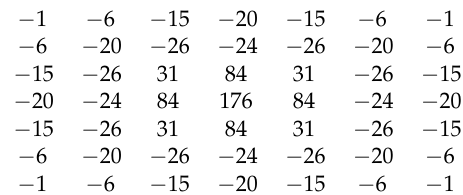
Table 3. Coefficients of the 7 × 7 convolution kernel for the Difference of Gaussian (DoG) filter.